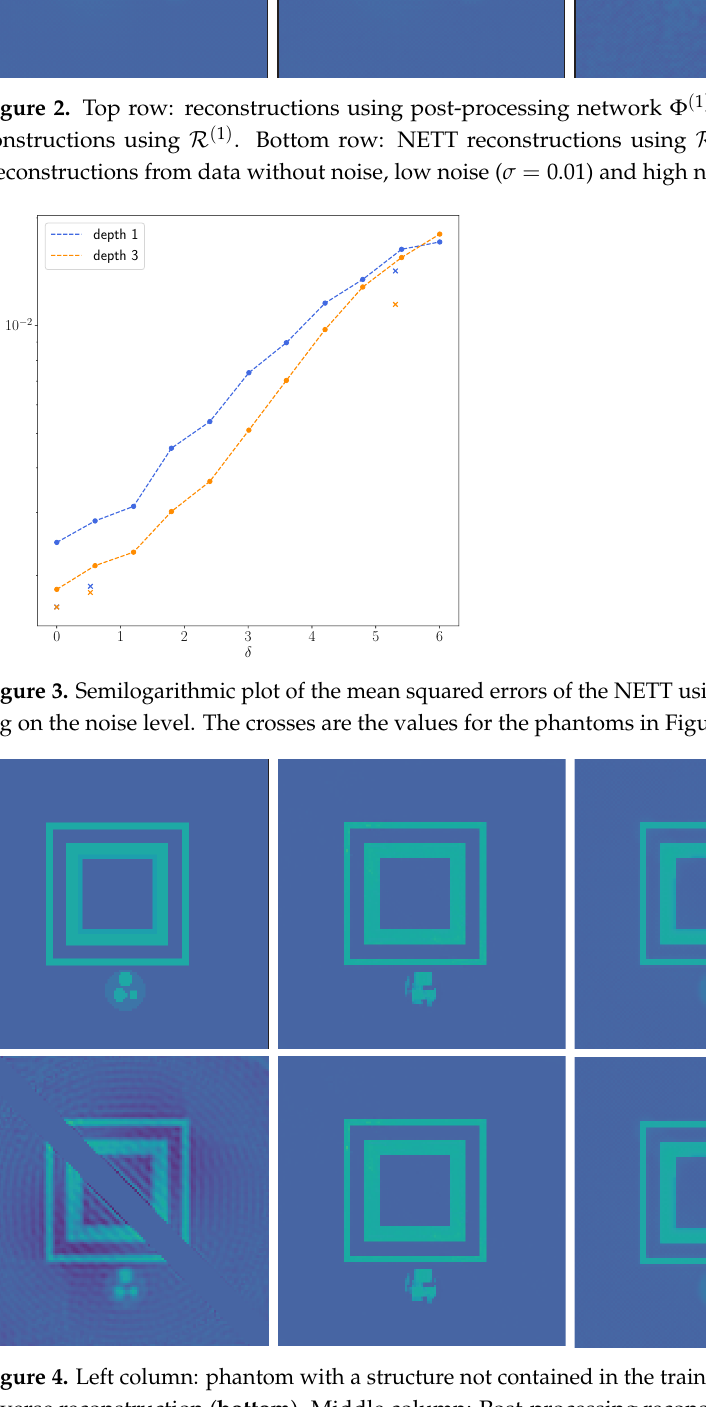
( 3 ) using exact ( top ) R